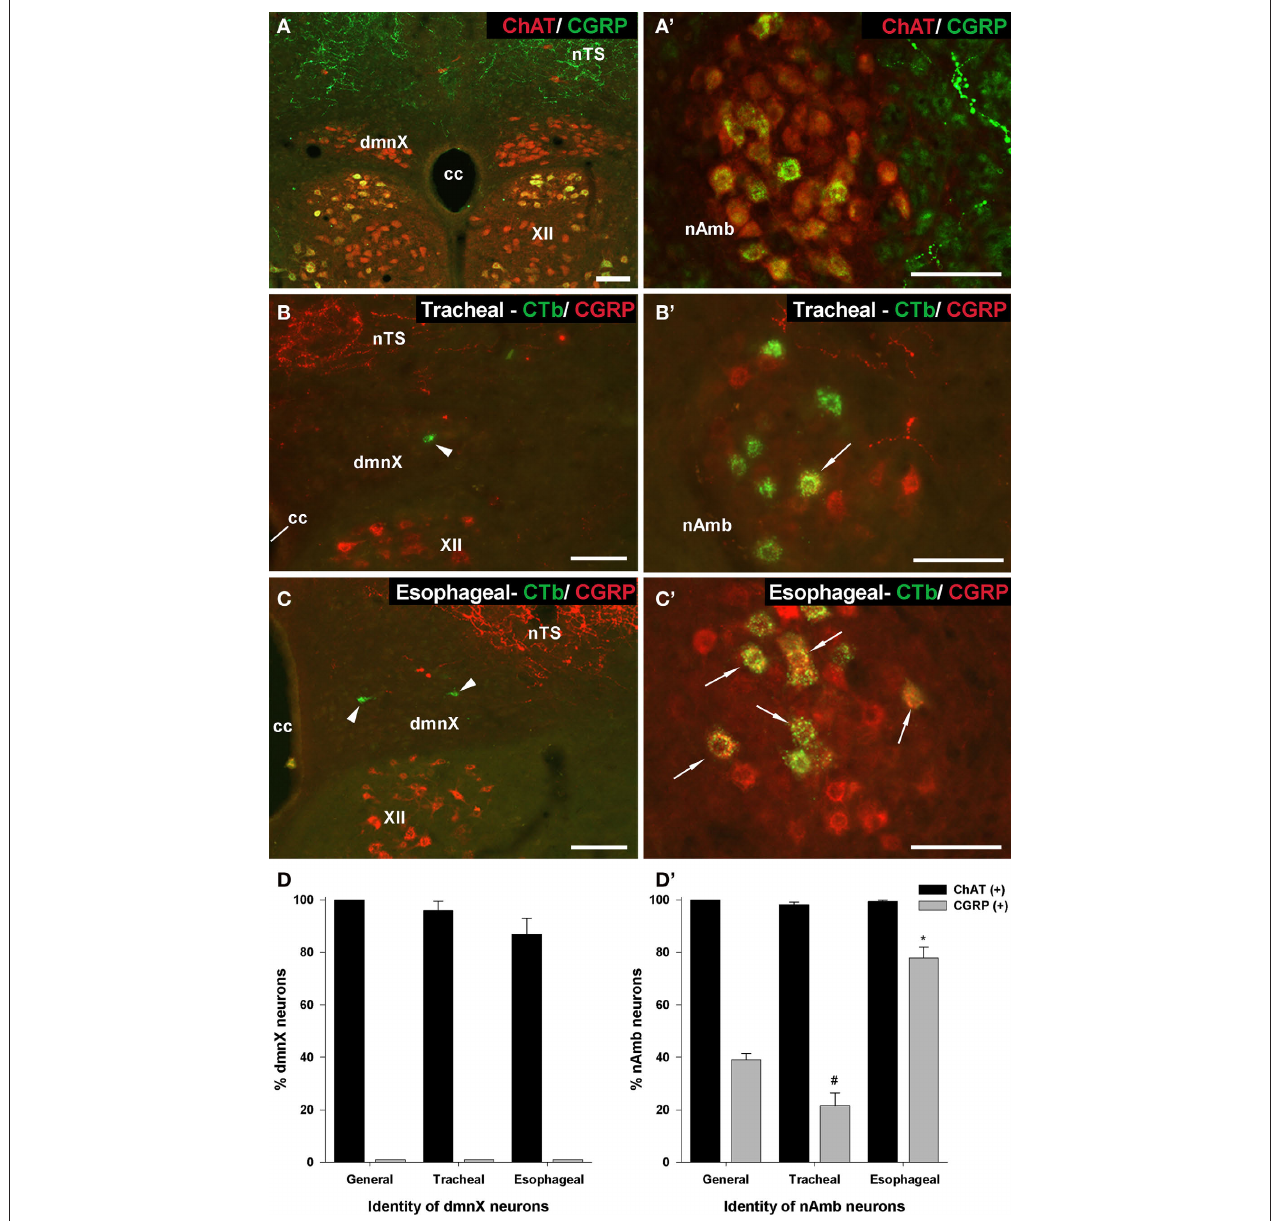
(arrow heads) expressed CGRP. Some CTb labeled neurons in the nAmb (arrows) expressed CGRP (double labeled neurons appear yellow). (D,D ′ ) Bar charts showing quantitative analysis of ChAT and CGRP expression in the general population of ChAT positive dmnX or nAmb neurons versus neurons retrogradely traced from either the trachea or esophagus. # P < 0.05 significantly less than the general population. * P < 0.05 significantly greater than the general population. The scale bars represent 100 μm. cc, central canal; nTS, nucleus of the solitary tract; XII, hypoglossal